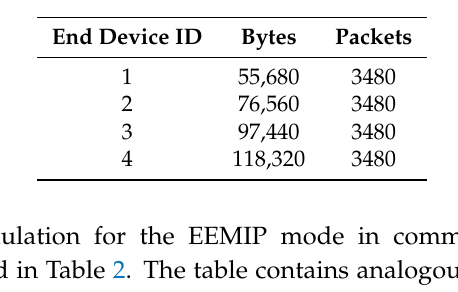
Table 1. Number of processed bytes in the nonbeacon ZigBee mode without retransmissions.